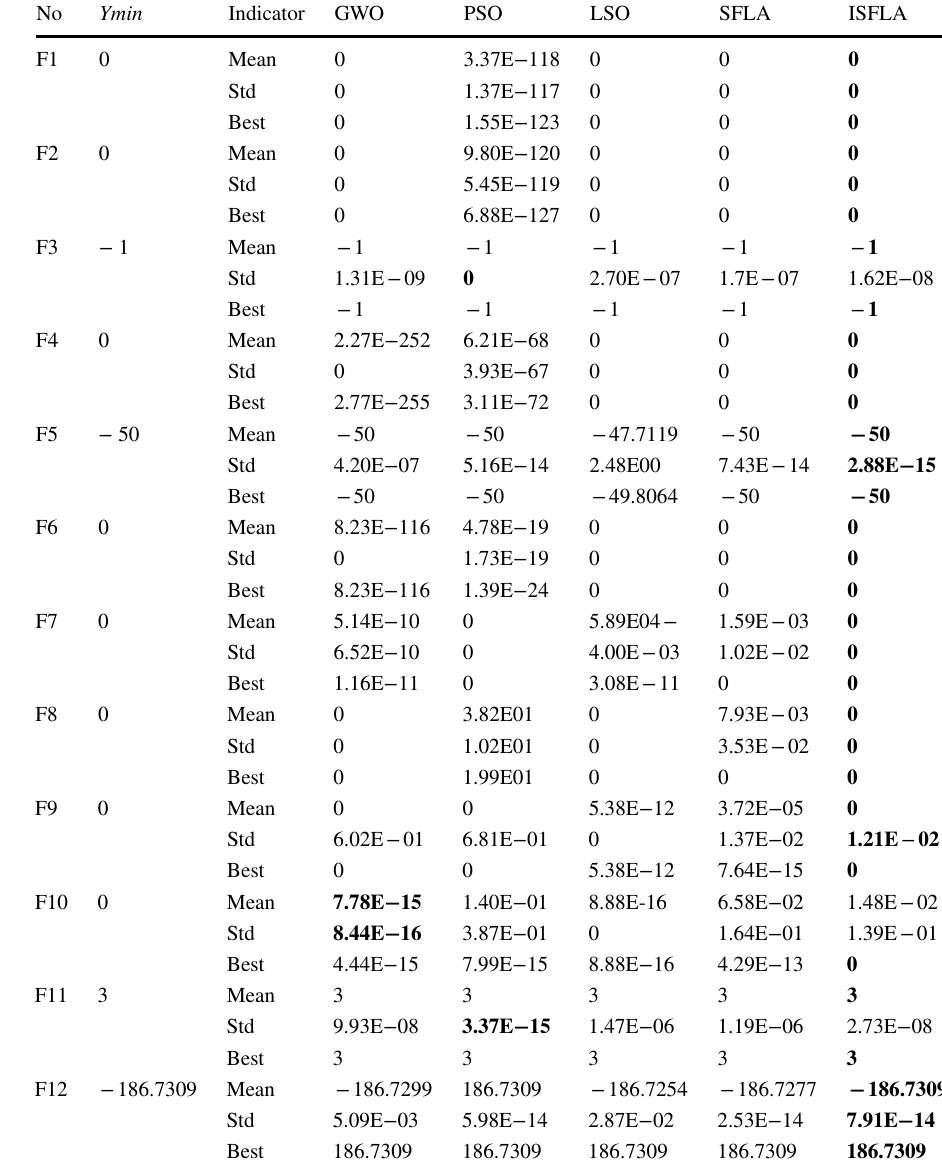
comparison under a fixed iteration